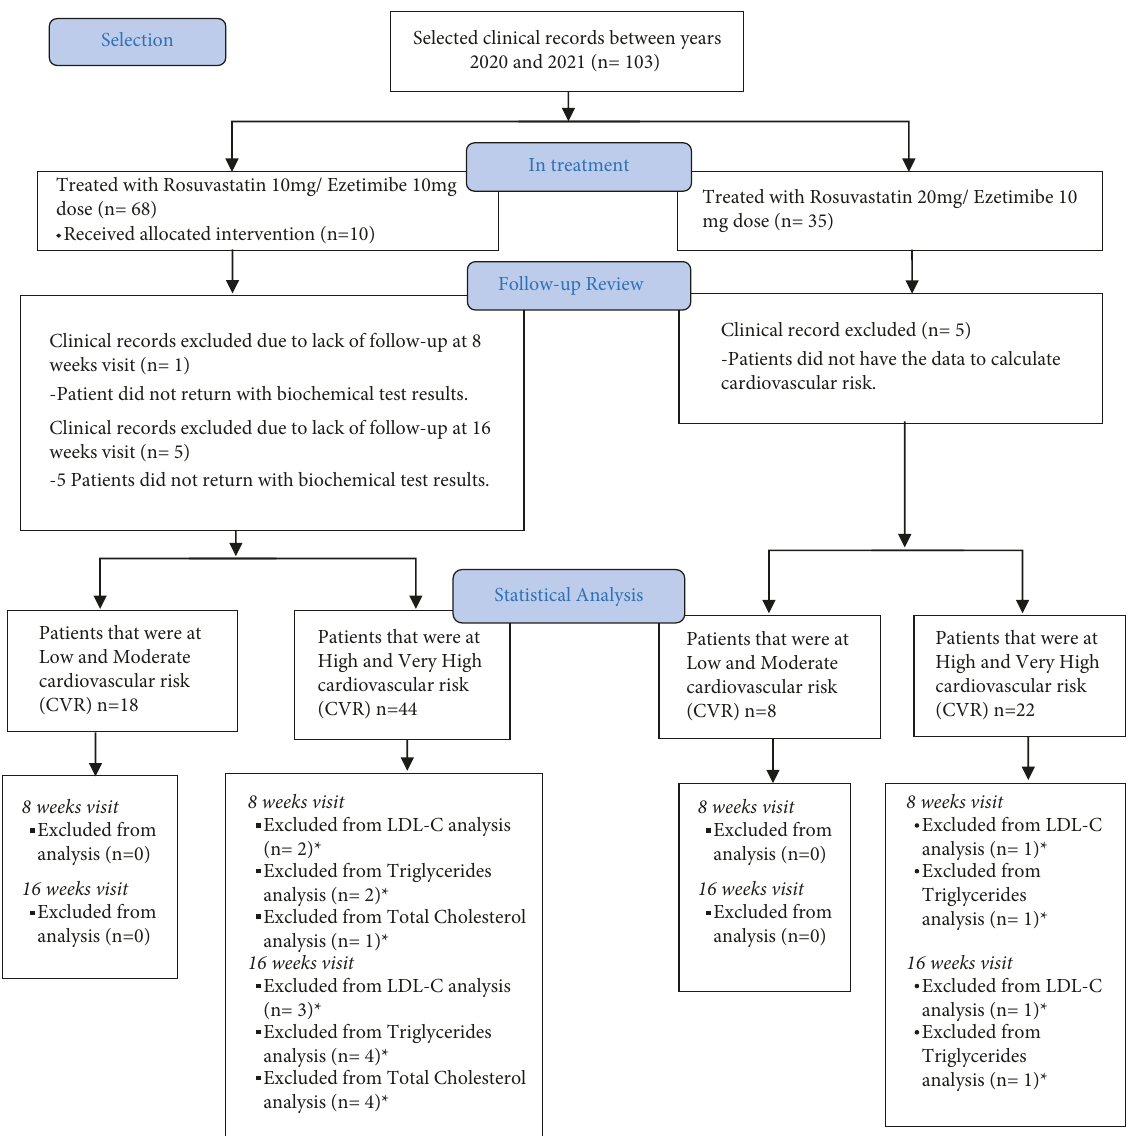
Figure 1: Flowchart of selection and analysis of patient clinical records. ∗ Patients did not have data for this lipid